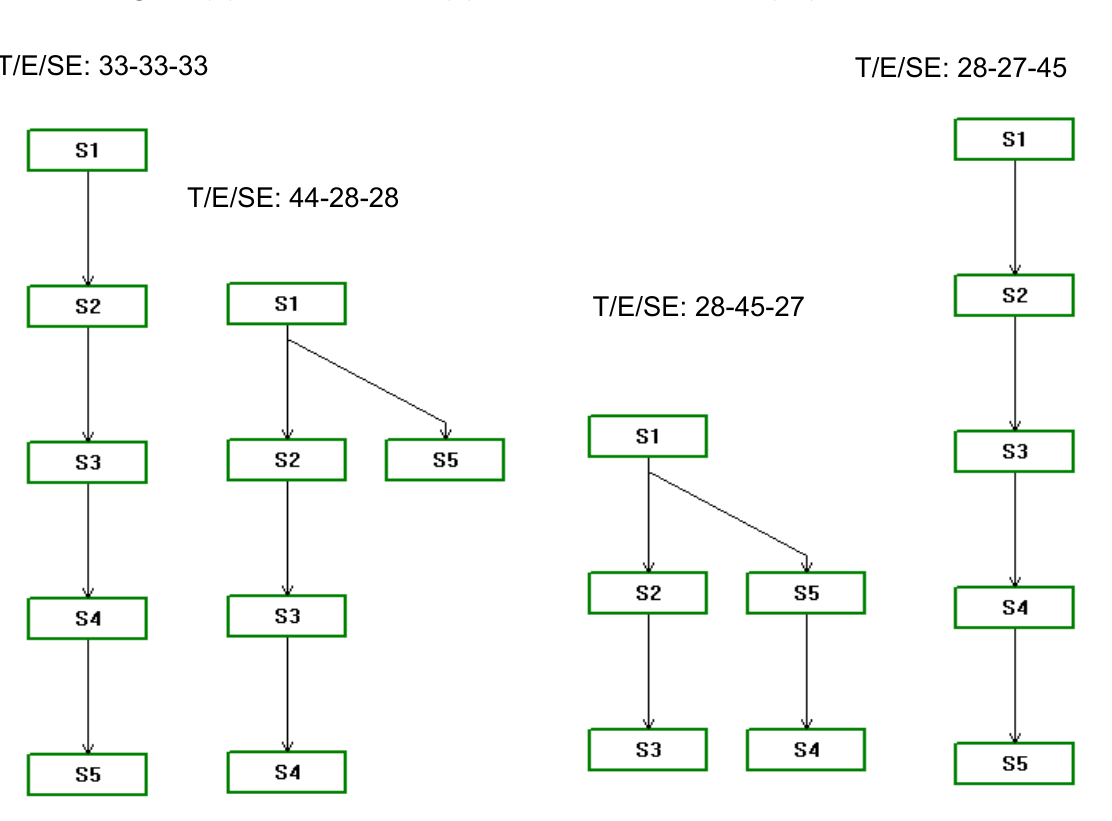
Figure 3. Results in relation to four scenarios of different importance of the Technological (T), Environmental (E) and Socio-Economical (SE)